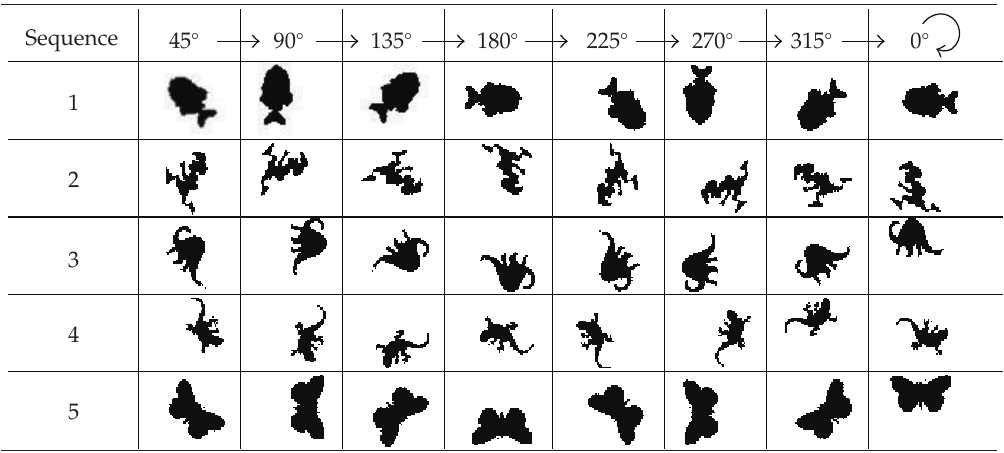
Table 11: Five binary sequences composed of 8 time steps.